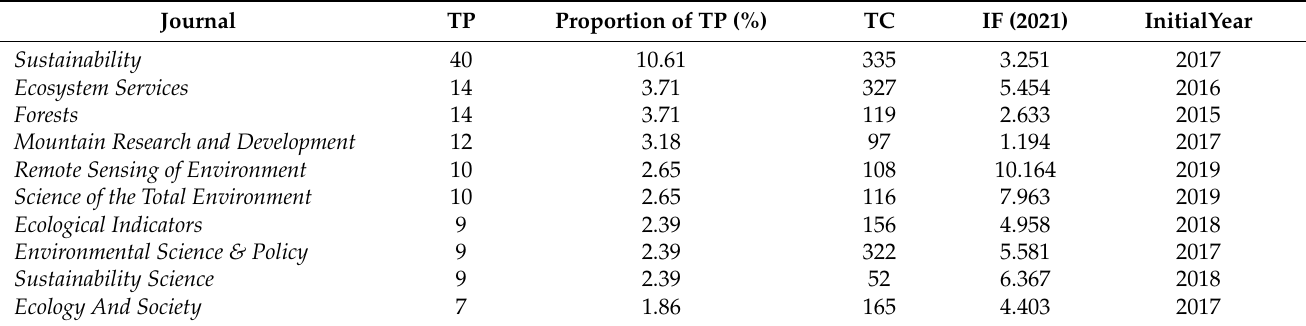
Table 1. Top 10 productive journals in the research of forestry and SDGs.